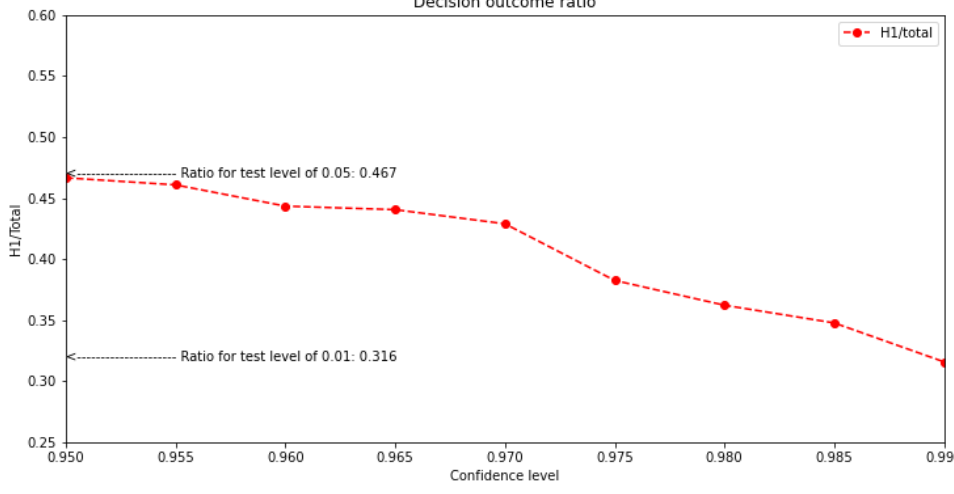
Figure 8. H1 decision outcome ratio vs. 1—test level.